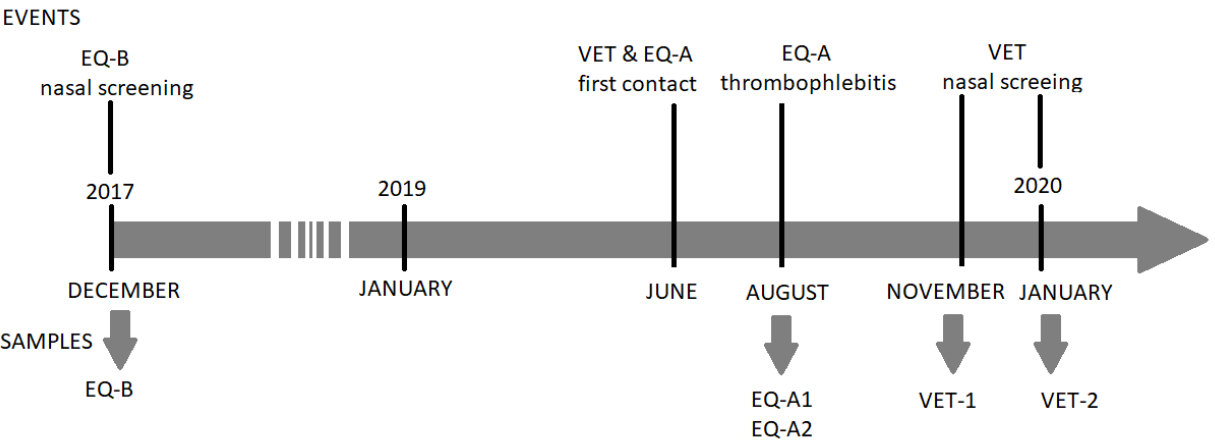
Figure 1. Timeline of the sampling